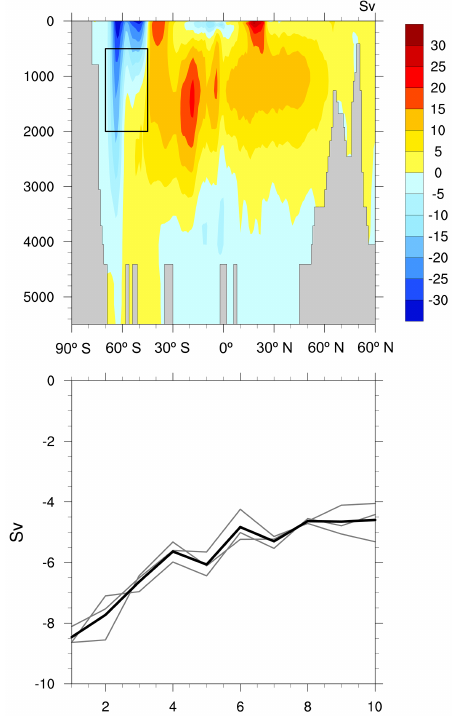
Figure 13. Atlantic Ocean Meridional Overturning stream function in September averaged for all decadal hindcasts from 1981 to 2015 for GEOS-5 (upper panel) and time series of stream function aver- aged over 45–70 ◦ N, 500–2000m as indicated by the black box in the upper panel (lower panel). The thin gray line represents each ensemble member, and the thick black line represents the ensemble